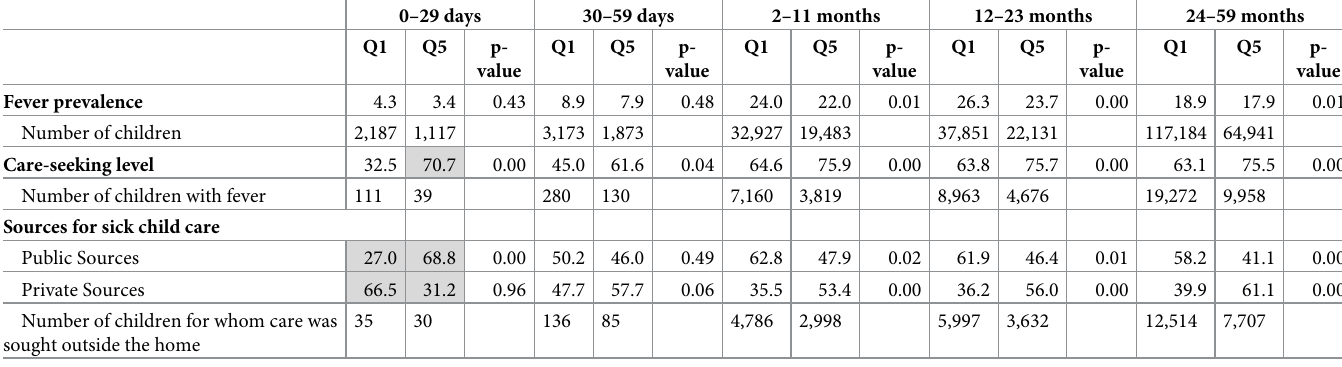
Table 5. Fever prevalence, care-seeking level, and sources of care by socioeconomic status within each age group.